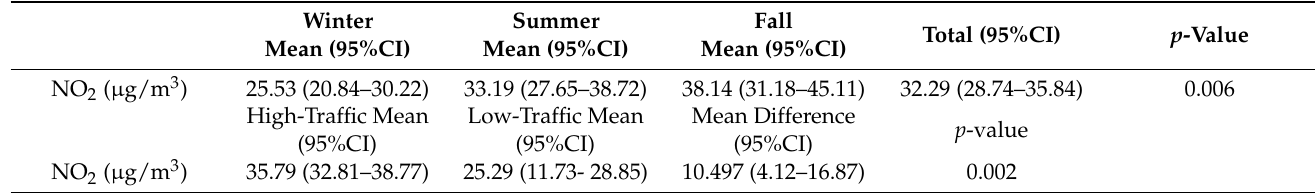
Table 3. Comparison of NO 2 Variation by Season and Traffic Density.